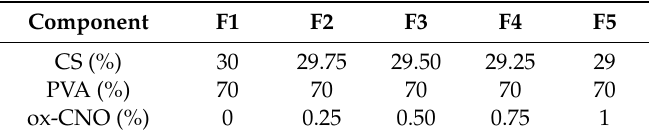
Table 1. Formulations used for the preparation of chitosan (CS) / poly(vinyl alcohol) (PVA) / oxidized carbon nano-onion (ox-CNO) nanocomposite